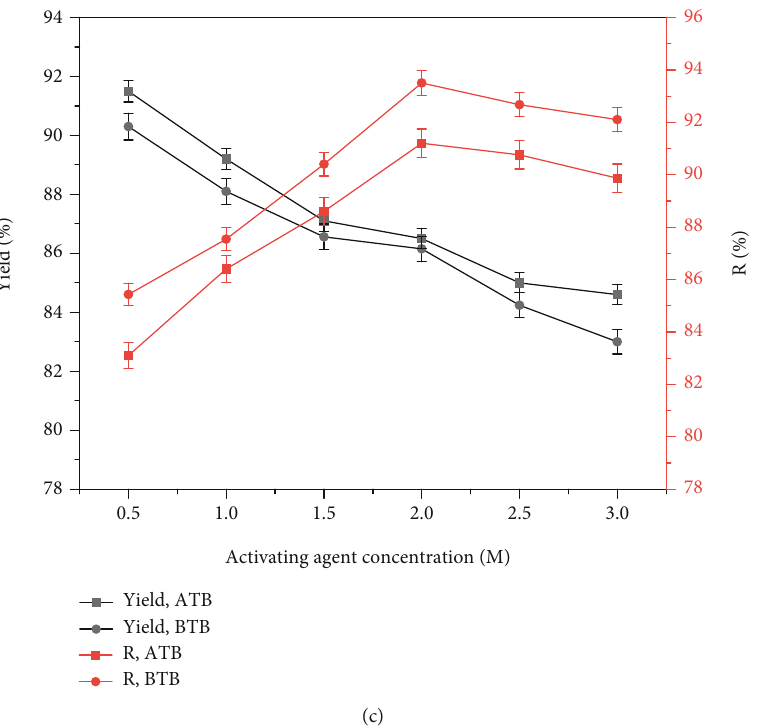
Figure 2: Results of yield (%) and R ð % Þ of biosorbent on (a) modi fi cation temperature, (b) modi fi cation time, and (c) activating agent concentration.